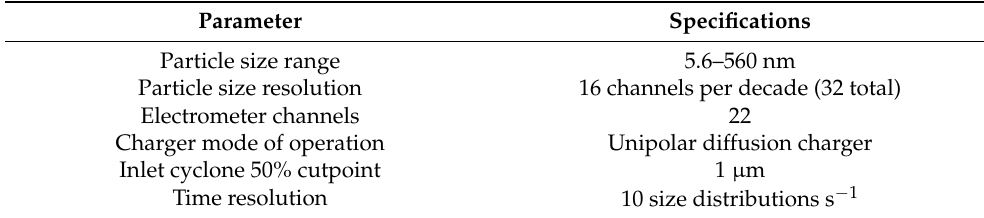
Table 6. Specifications of the